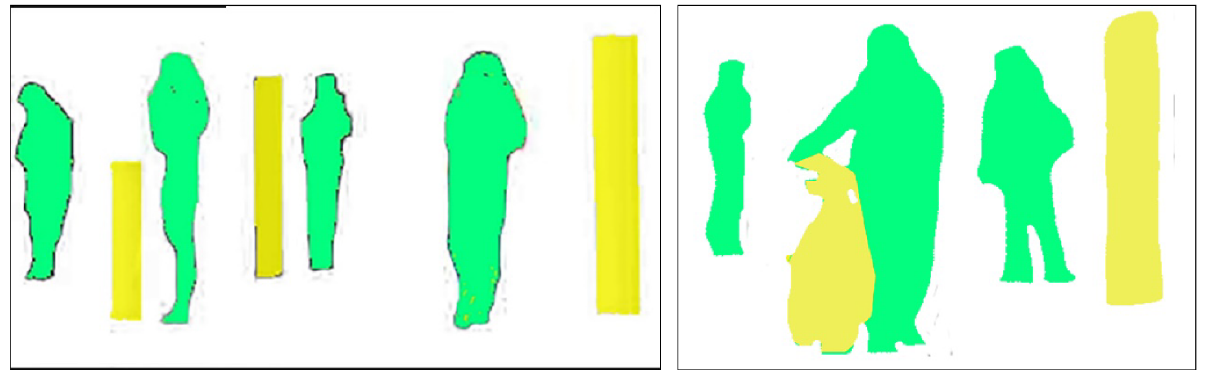
Figure 3. Optimized results of pre-processing step with human and non-human objects. The yellow color indicates non-human objects, whereas the green color indicates human silhouette.